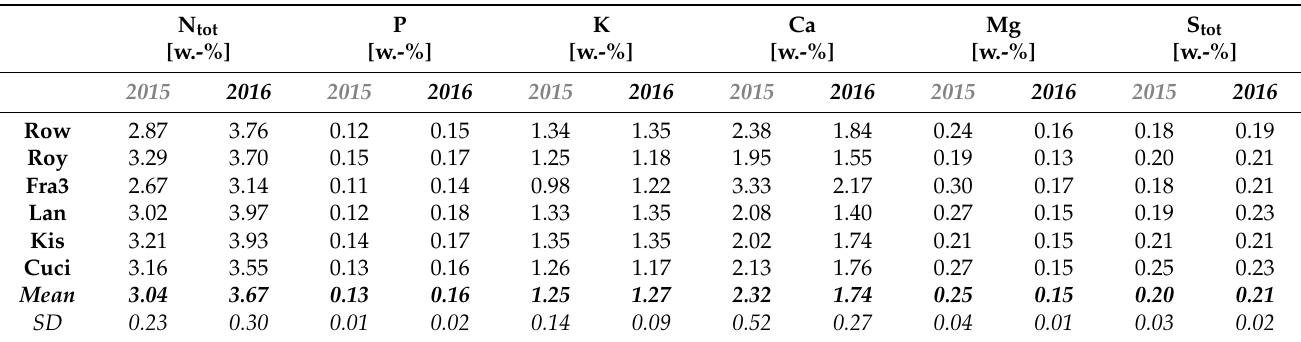
Table 6. Results of the determination of plant nutrients in the leaf tissue of Robinia test trees taken on 10 August 2015 and 10 August 2016 at clonal test plot Welzow . The font colour and italics are stylistic instruments.